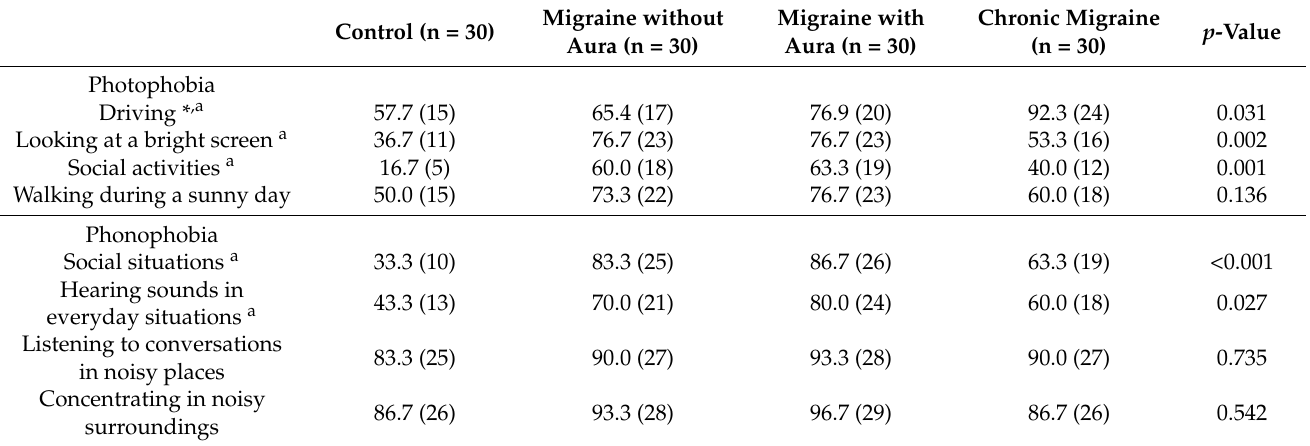
Table 2. Prevalence (%, n) of interictal photophobia and phonophobia during daily activities. Migraine without Migraine with Chronic Migraine p Control (n = 30) Aura (n = 30) Aura (n = 30) (n = 30)